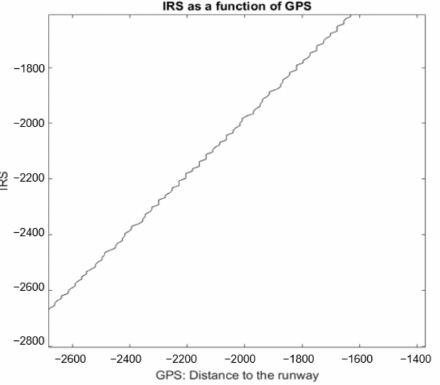
Figure 11. IRS portion as a function of GPS (real values for the X